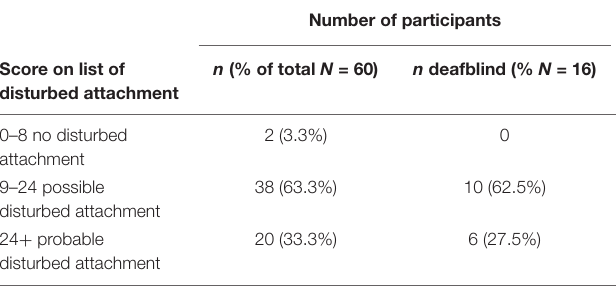
TABLE 1 | Distribution of attachment categories.